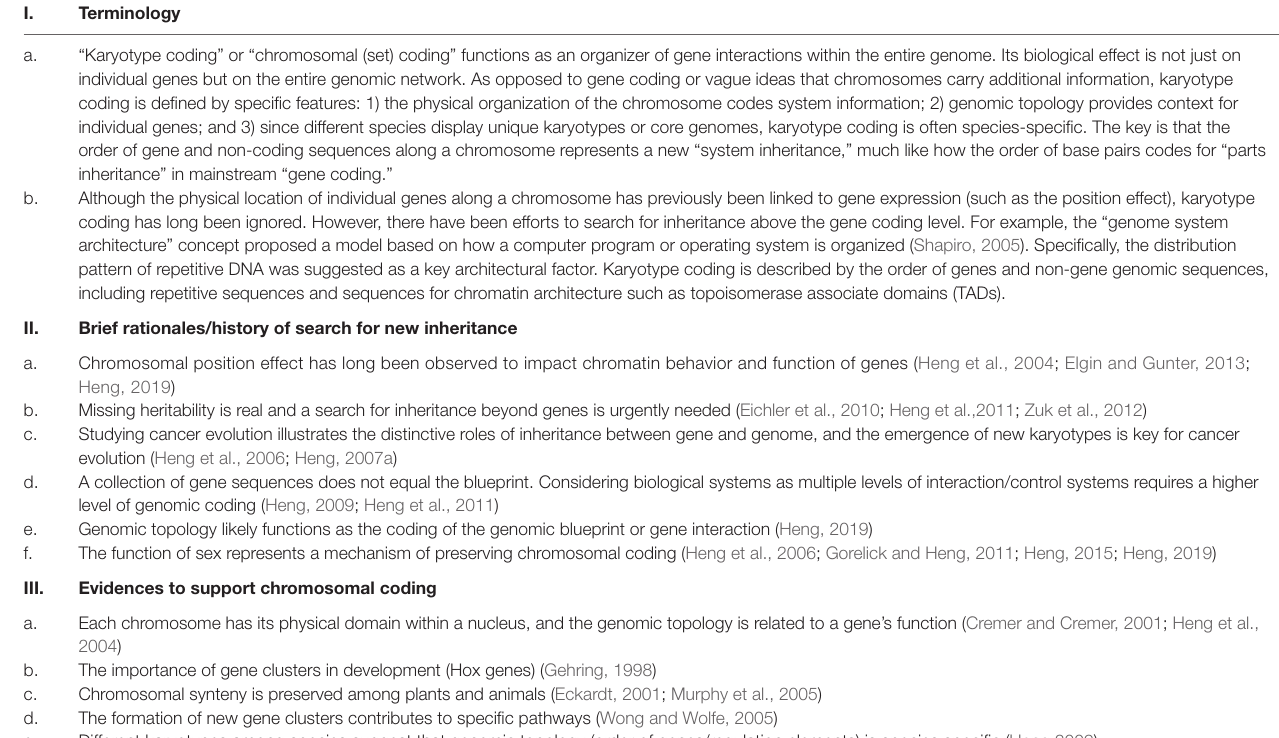
TABLE 1 | Terminology/rationales/evidences/implications of karyotype-coded system